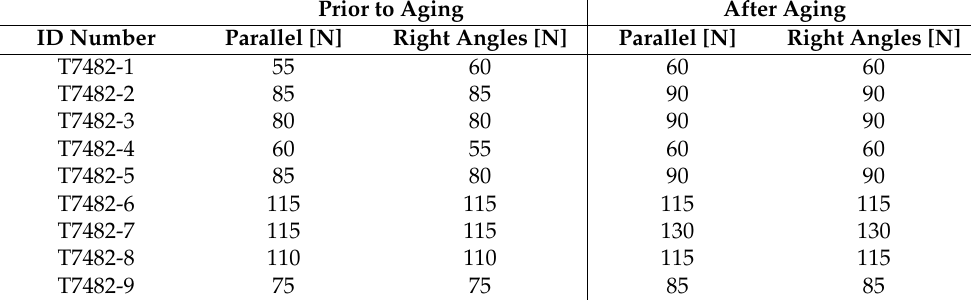
Table 7. Thickness and mass before aging.